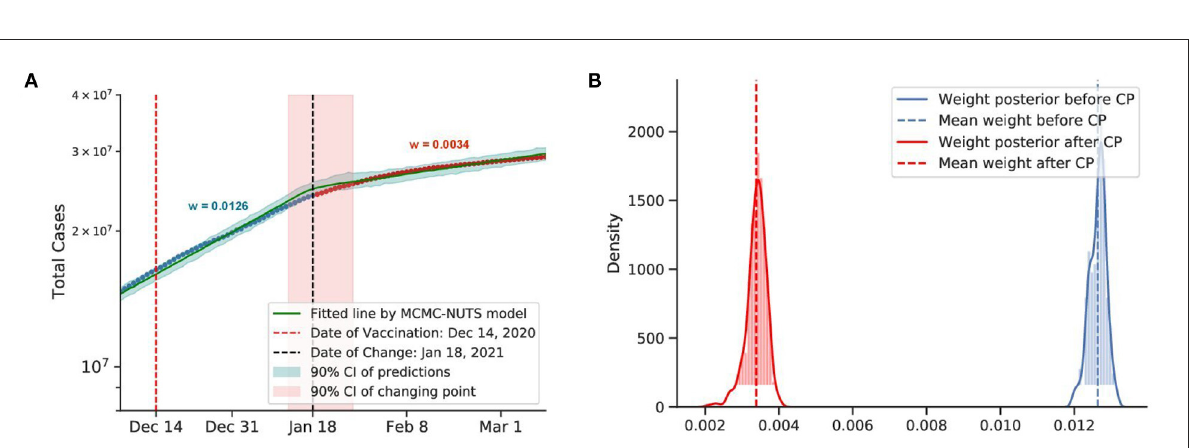
FIGURE11 Posterior for the US. The US recorded more than 20 million cases when they start vaccine program on December 14, 2020 (77), US sees the growth rate declined by 73%, from 0.0126 to 0.0034. The change-point point was around January 18, 2021. (A) Fitted graph with change-point on January 18, 2021. (B) Posterior distribution of weights (transmission rate) before and after change-point.